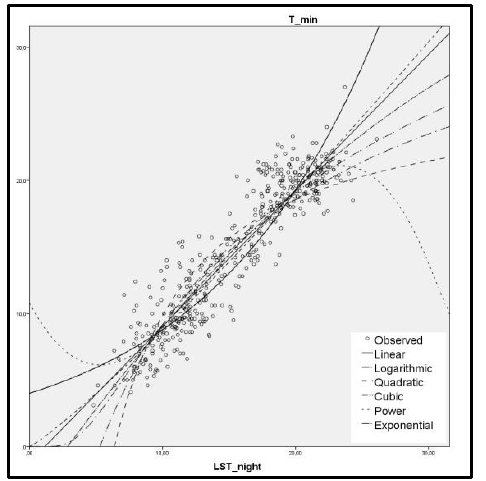
Figure 5. Correlation between nighttime MODIS LST and T min